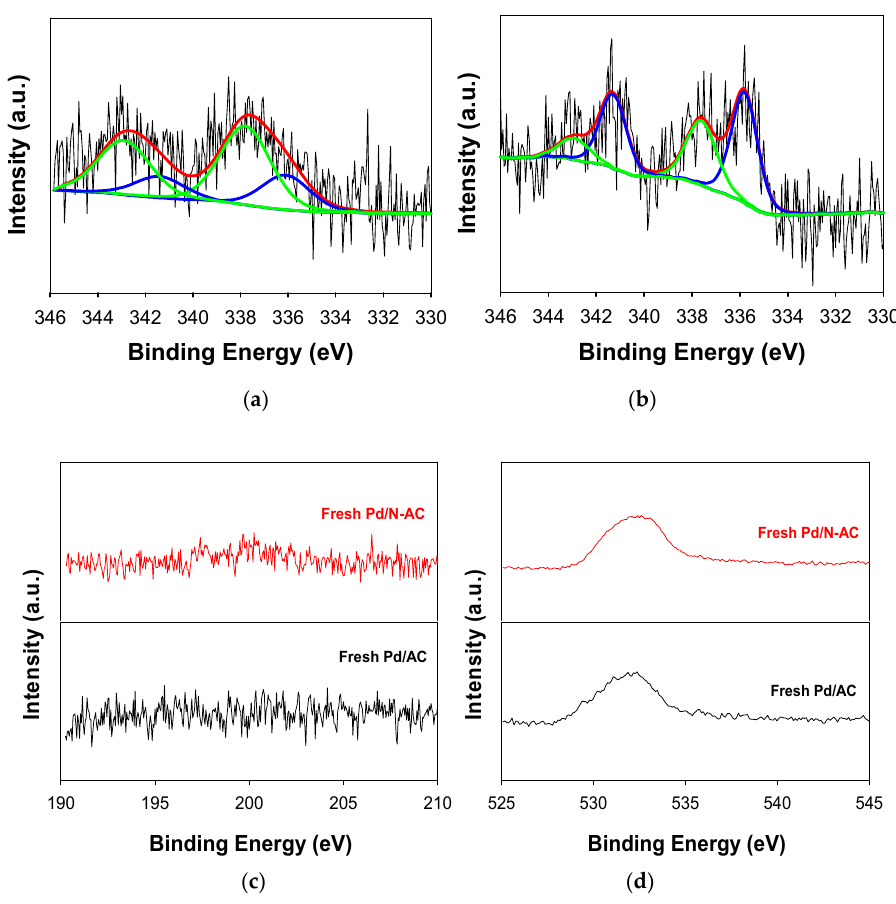
Figure 4. Pd 3d XPS spectra of fresh ( a ) Pd/AC and ( b ) Pd/N-AC catalysts. Cl 2p and O 1s XPS spectra of two catalysts: ( c ) Cl 2p and ( d ) O1s. The raw data are shown by the black curve, and the fitting curve is indicated by the red curve. The decomposed peaks are presented by the blue (Pd 0 ) and green (Pd 2+ ) curves.